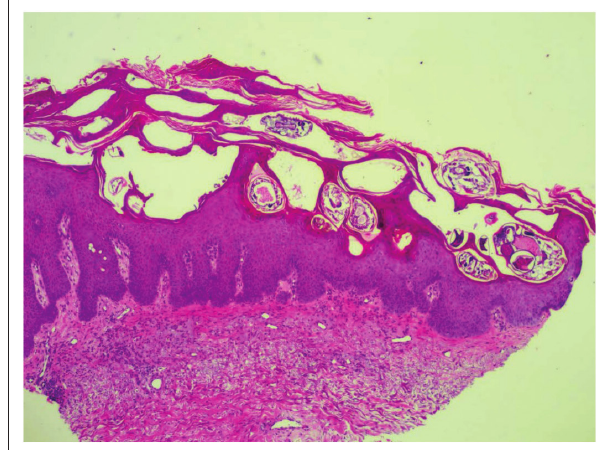
FIGURE 7: Honeycombed stratum corneum with scabies mites and ova (magnification x40).